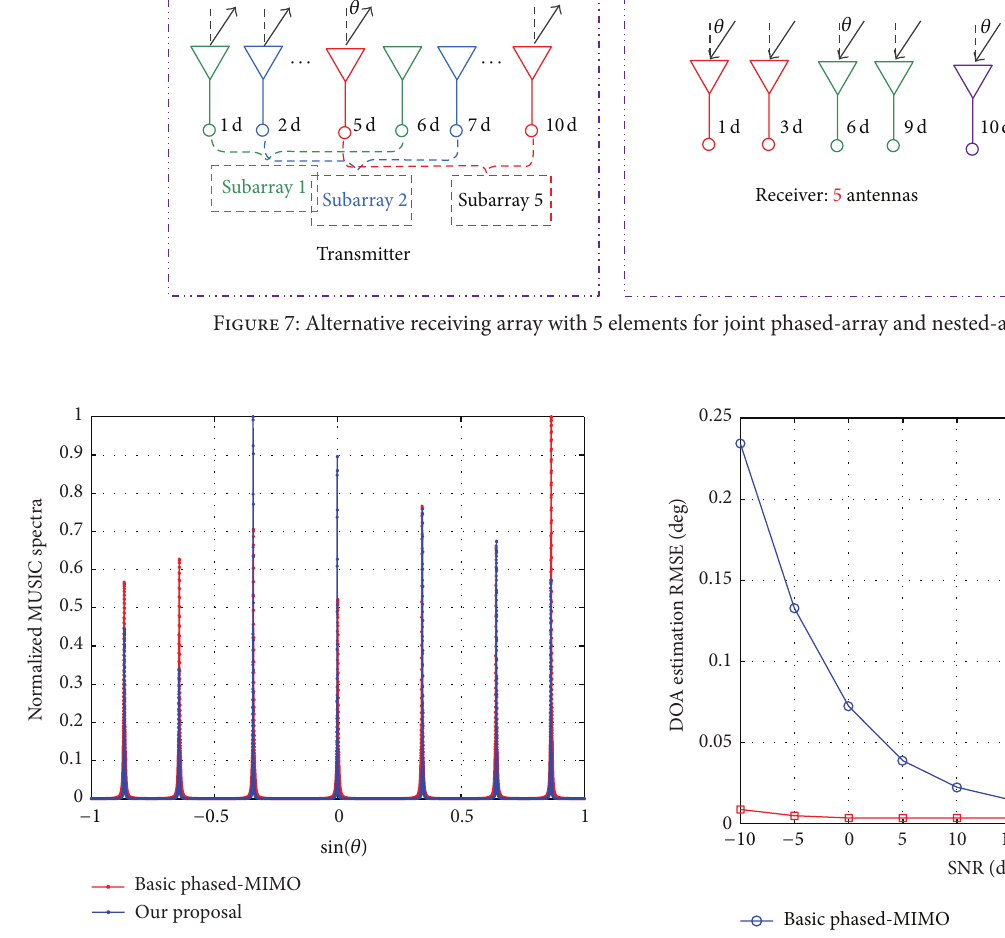
Figure 8: Comparative MUSIC spectra for the alternative receiving array. Figure 9: Comparative RMSE versus SNR for Example 1.